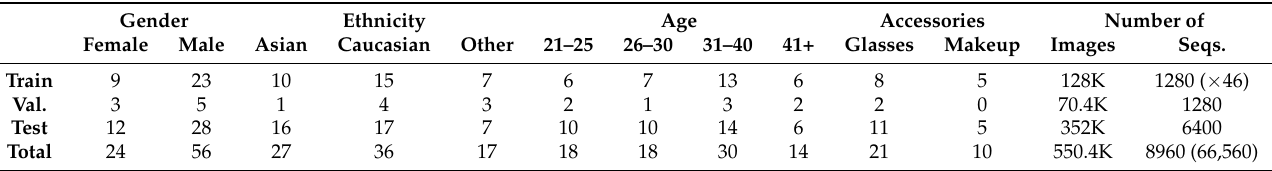
Table 2. Statistics of the gaze prediction data